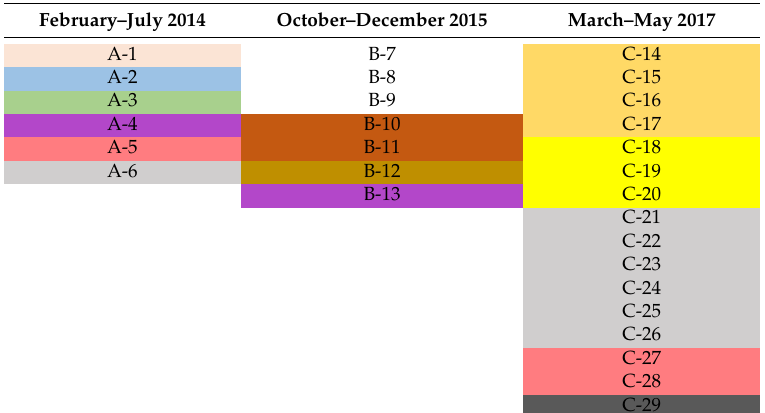
Table 1. Organization of the